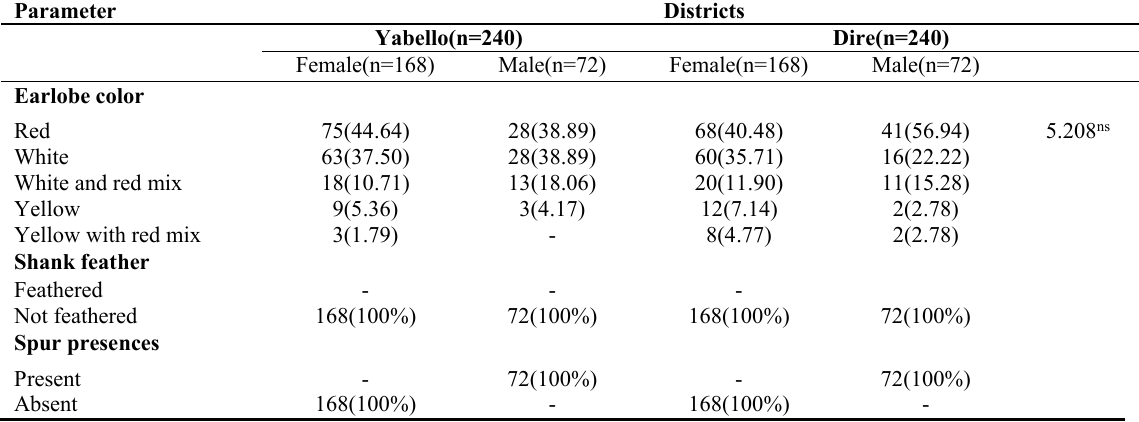
Table 2. Earlobe color variation and binomial traits in sampled chicken